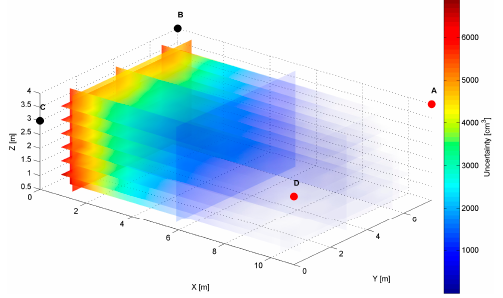
Figure 7. Volumetric slice plot of uncertainty-precision distribution for location sensors AD .